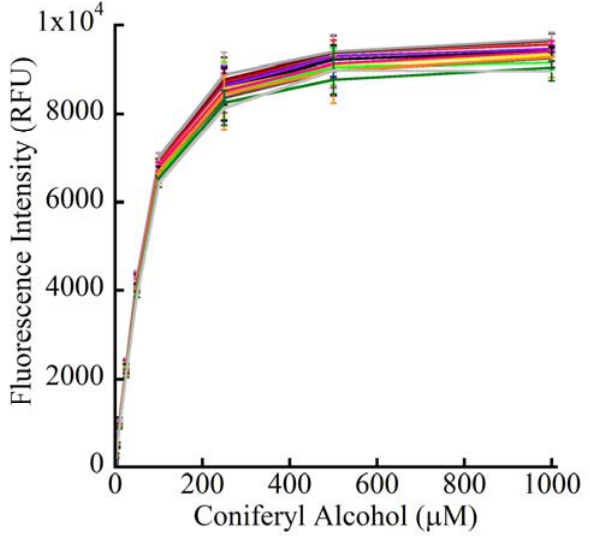
Figure 11A. Concentration dependence of CA photostability. Increasing concentrations of CA were dispensed into 384-well microplate. The data from the 25  L reactions (  ex, 310 nm;  em = 416 nm) are shown. The tracings represent measurements taken at the following intervals (min): 5 (black), 10 (blue), 20 (red), 30 (purple), 45 (bright green), 60 (yellow), 120 (aqua), 180 (maroon), 240 (dark grey), 300 (magenta), 360 (brown), 420 (orange), 480 (dark green) and 1440 (light grey).